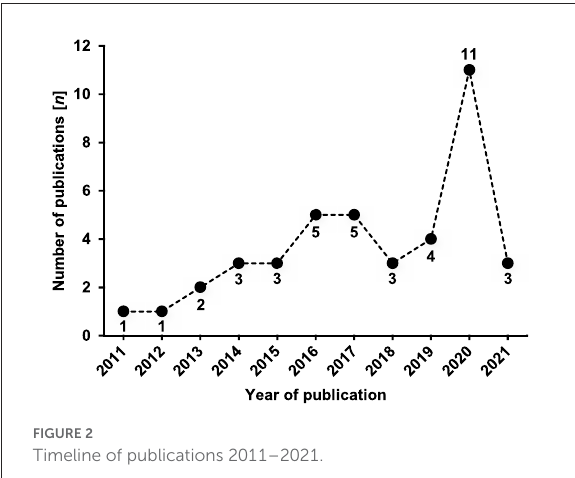
FIGURE2 Timeline of publications